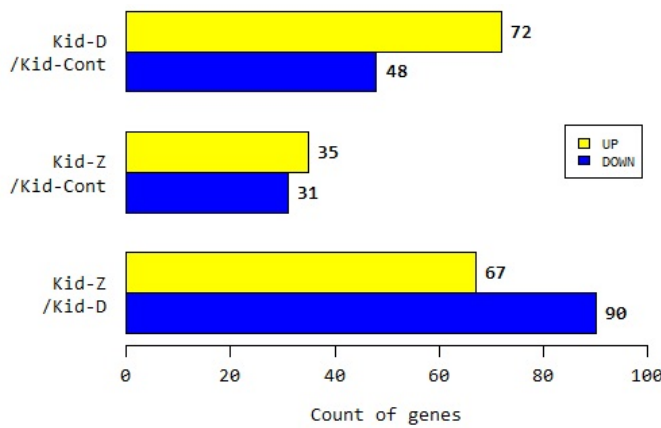
Figure 1. The number of up- and downregulated differentially expressed genes (DEGs) among the control, deoxynivalenol (DON), and zearalenone (ZEN) groups. The Y-axis represents the up- and downregulation of DEGs between control kidneys vs mycotoxin-treatment group kidneys. The X-axis represents the total number of transcripts (DEGs for each pairwise comparison were selected at fold change ≥2 and p≤0.05).